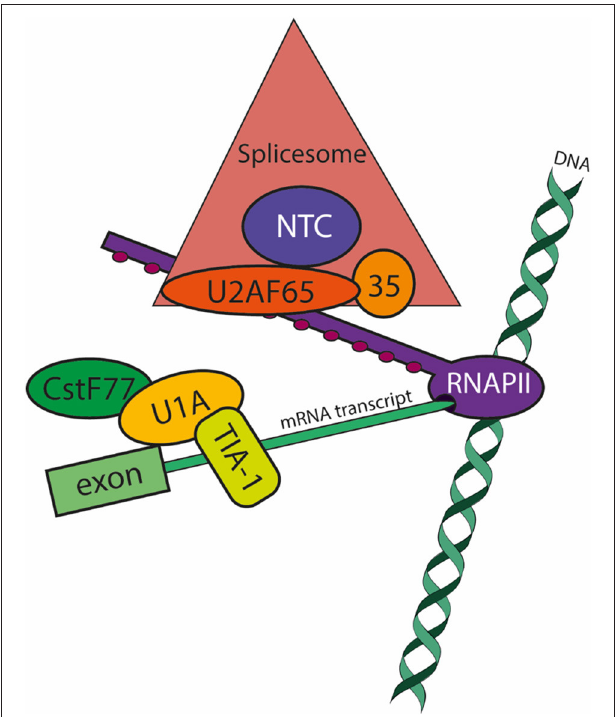
FIGURE 1 | Co-transcriptional pre-mRNA processing in E. histolytica : focus on splicing factors . The model summarizes the data available to date (Valdés et al., 2014 ). During transcript elongation by RNA polymerase II (RNAPII; purple), Ser2 residues of the few heptapeptide repeats of its carboxy-terminal domain become phosphorylated (PSer2-CTD; maroon circles) and apt to recruit the spliceosomal (salmon triangle) and polyadenylation machineries. The large subunit of the U2 Auxiliary Splicing Factor U2AF65 (of 84 kDa in E. histolytica ; orange oval) is a major player in pre-mRNA processing by tethering the spliceosome and the pre-mRNA (light green boxes) to RNAPII. U2AF65 interacts with the RNAPII-PSer2-CTD and with splicing factors conforming the Prp19 Complex (NTC; blue circle). The NTC regulates the formation and progression of essential spliceosome conformations required for the two steps of spacing. Splicing complex E formation occurs when the snRNP U1-A (yellow oval) binds to the 5 ′ ss (splice site) and the splicing factor TIA-1/TIAR (yellow box) binds to the U-rich sequence just downstream the 5 ′ ss. Splicing complex E also involves the 3 ′ ss definition (not shown). When RNAPII releases the 3 ′ ss from the transcription site, splicing factor 1 binds the branch site at the same time that U2AF65 binds the intron’s polypyrimidine tract located between the branch site and the 3 ′ ss; also simultaneously, the small subunit of U2AF (U2AF35, of 29 kDa in E. histolytica ; pale orange circle) recognizes the 3 ′ ss. The interaction of U2AF65 with splicing factor 1 and U2AF65 at the 3 ′ ss and with the CTD of RNAPII ensures that U2AF65 also tethers the pre-mRNA to RNAPII. Finally, in addition to the previously reported interactions of RNAPII with the polyadenylation complex (vide infra), U1-A directly or indirectly interacts with the splicing complexes B-C, and more importantly with CstF77 (dark green oval), a member of the polyadenylation machinery.